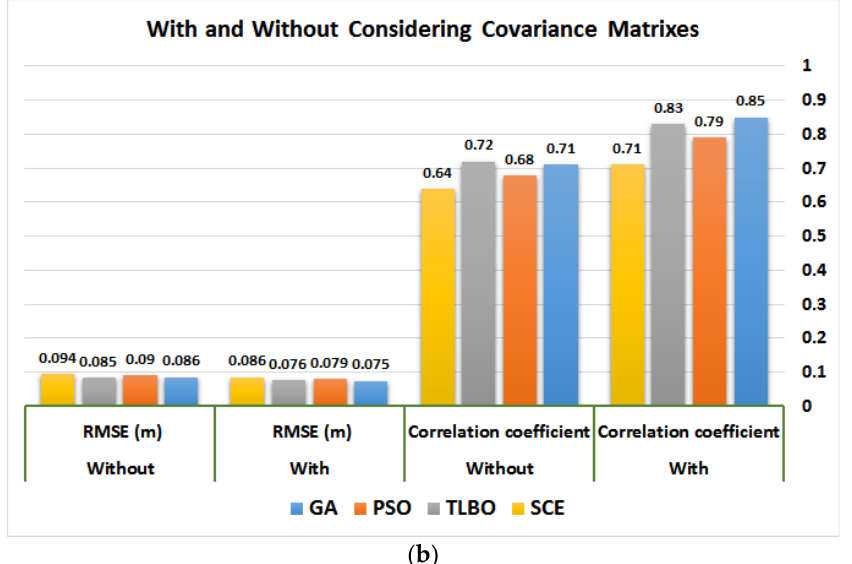
Figure 3. ( a ) The performance of each optimization method at tide gauge stations with and without considering covariance matrices. ( b ) The performance of each optimization method at current meter stations with and without considering covariance matrices.